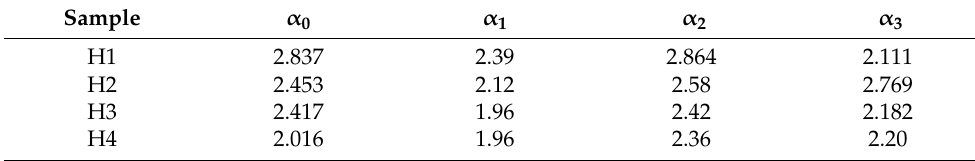
Table 7. N 2 /O 2 gas selectivity-coefficients, pure and in mixture of the studied zeolites.